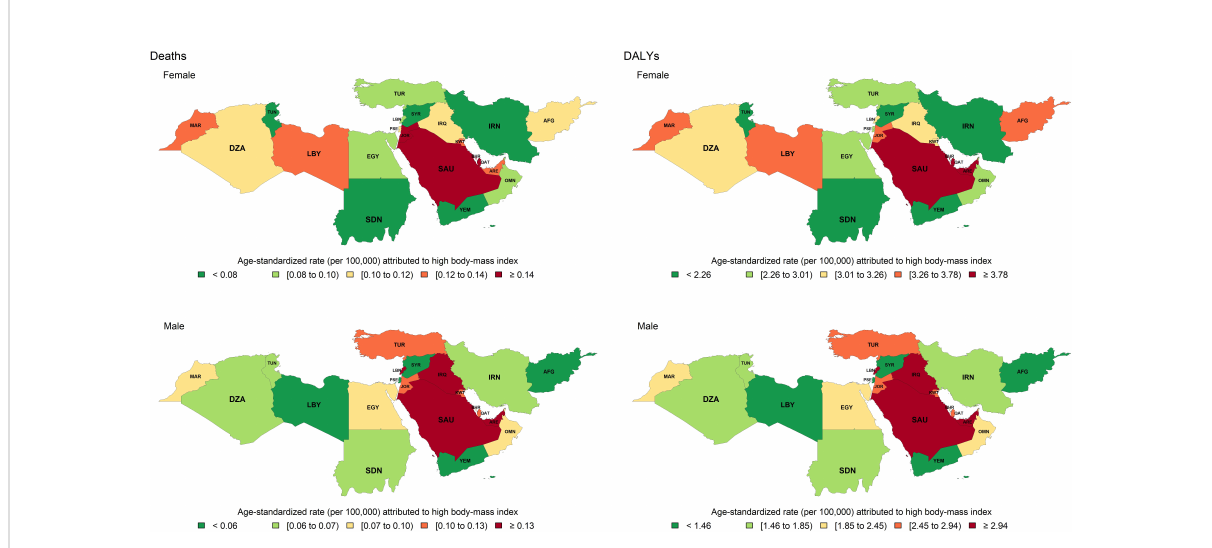
FIGURE 4 Age-standardized rate of death and disability-adjusted life years (DALYs) of thyroid cancer attributable to high body mass index (BMI) in North Africa and Middle East region in 2019, by sex and country. AFG, Afghanistan; DZA, Algeria; BHR, Bahrain; EGY, Egypt; IRN: Iran (Islamic Republic of); IRQ, Iraq; JOR, Jordan; KWT, Kuwait; LBN, Lebanon; LBY, Libya; MAR, Morocco; OMN, Oman; PSE, Palestine; QAT, Qatar; SAU, Saudi Arabia; SDN, Sudan; SYR, Syrian Arab Republic; TUN, Tunisia; TUR, Turkey; ARE, United Arab Emirates; YEM, Yemen.